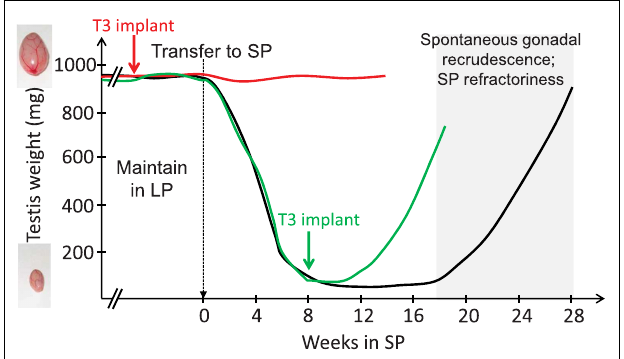
FIGURE 1 |T3 implants prevent SP-induced inactivation of the gonadal axis (red line) and reactivate the gonadal axis in SP-adapted Siberian hamsters [green line; after data from Barrett et al. (54) and Murphy et al. (55)] . Siberian hamsters (black line) kept in LP remain indefinitely sexually active (broken lines) unless they are transferred to SP; gonads then progressively regress (testes depicted here, but data are similar for female reproductive organs). However, prolonged SP exposure leads to a spontaneous recrudescence of the gonads, which reflects